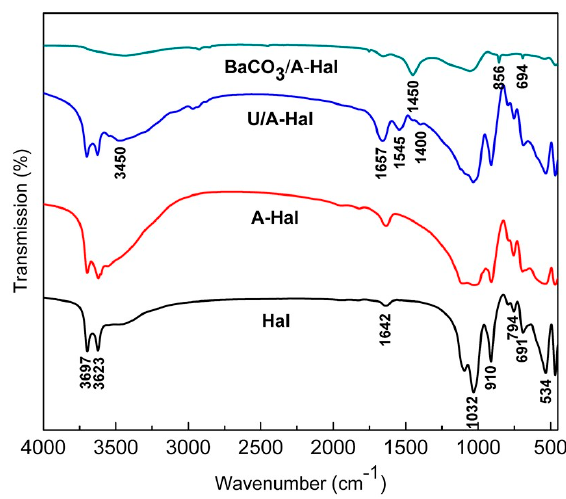
Figure 3. FTIR spectra of the raw Hal, A-Hal, U/A-Hal and BaCO 3 /A-Hal-T samples. Table 1. Positions and assignments of the FTIR vibration bands of different samples.